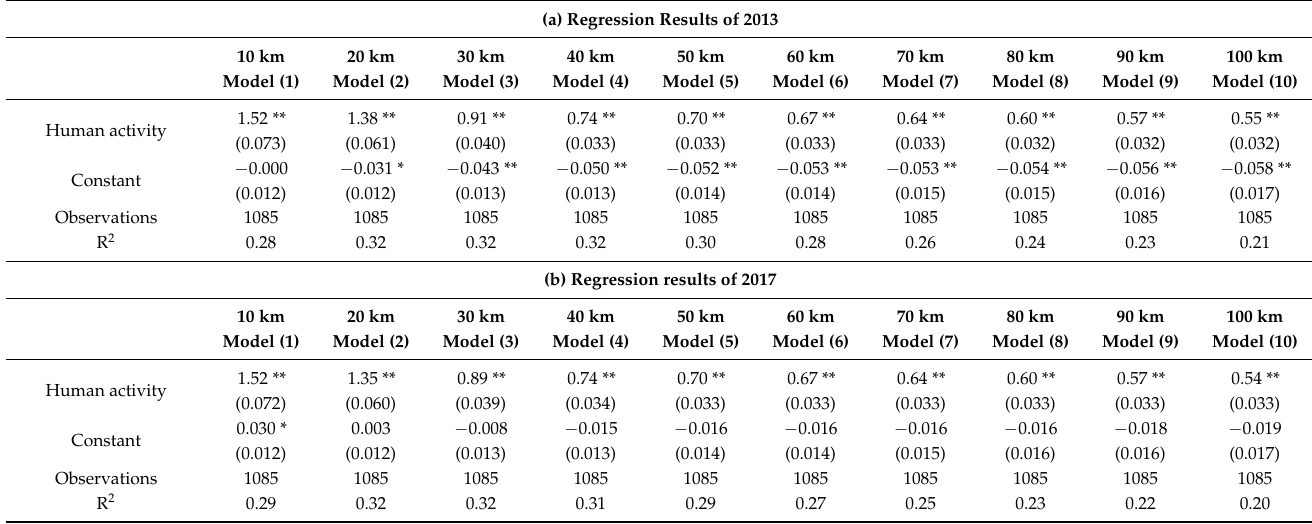
Table 4. Correlation between NTL in PAs and human activities at different distances. (a) Regression Results of